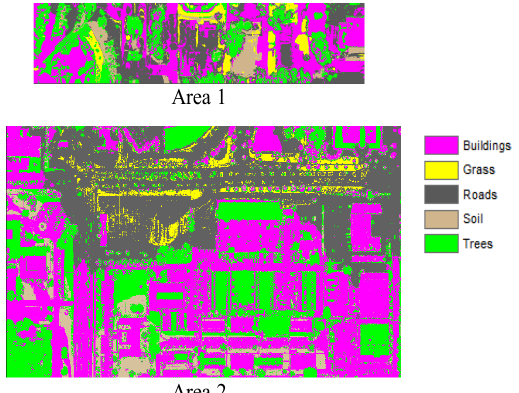
Figure 6. Classification Results of the Raster Format Data